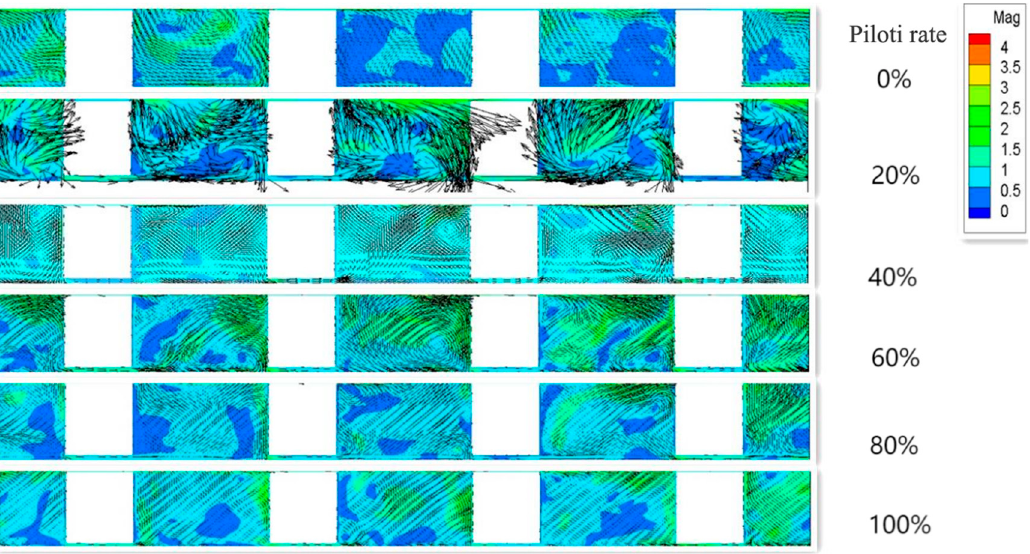
Figure 14. Vector diagram of the target area of Section 1 (Point model).